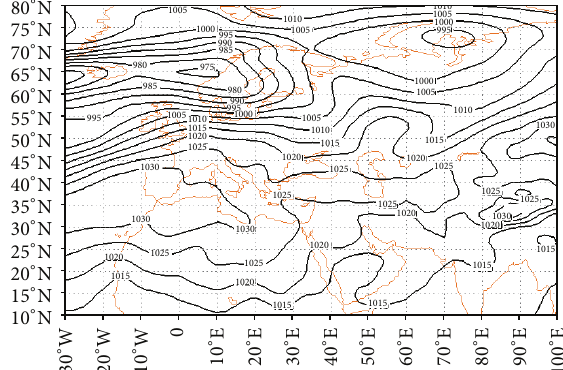
Figure 15: Sea level pressure map.